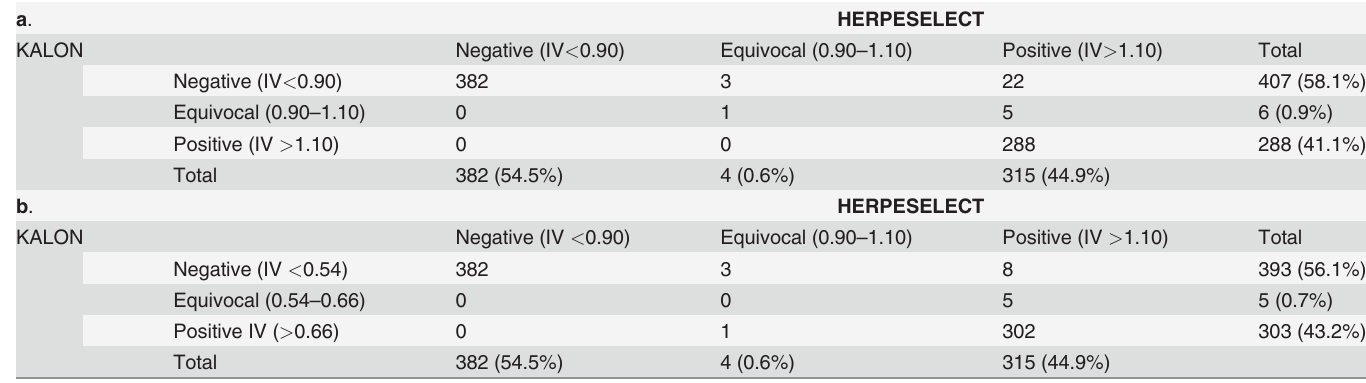
Table 1. Baseline results for both assays using the manufacturer ’ s instructions (a) and the lowered cut-off of 0.66 for the Kalon assay